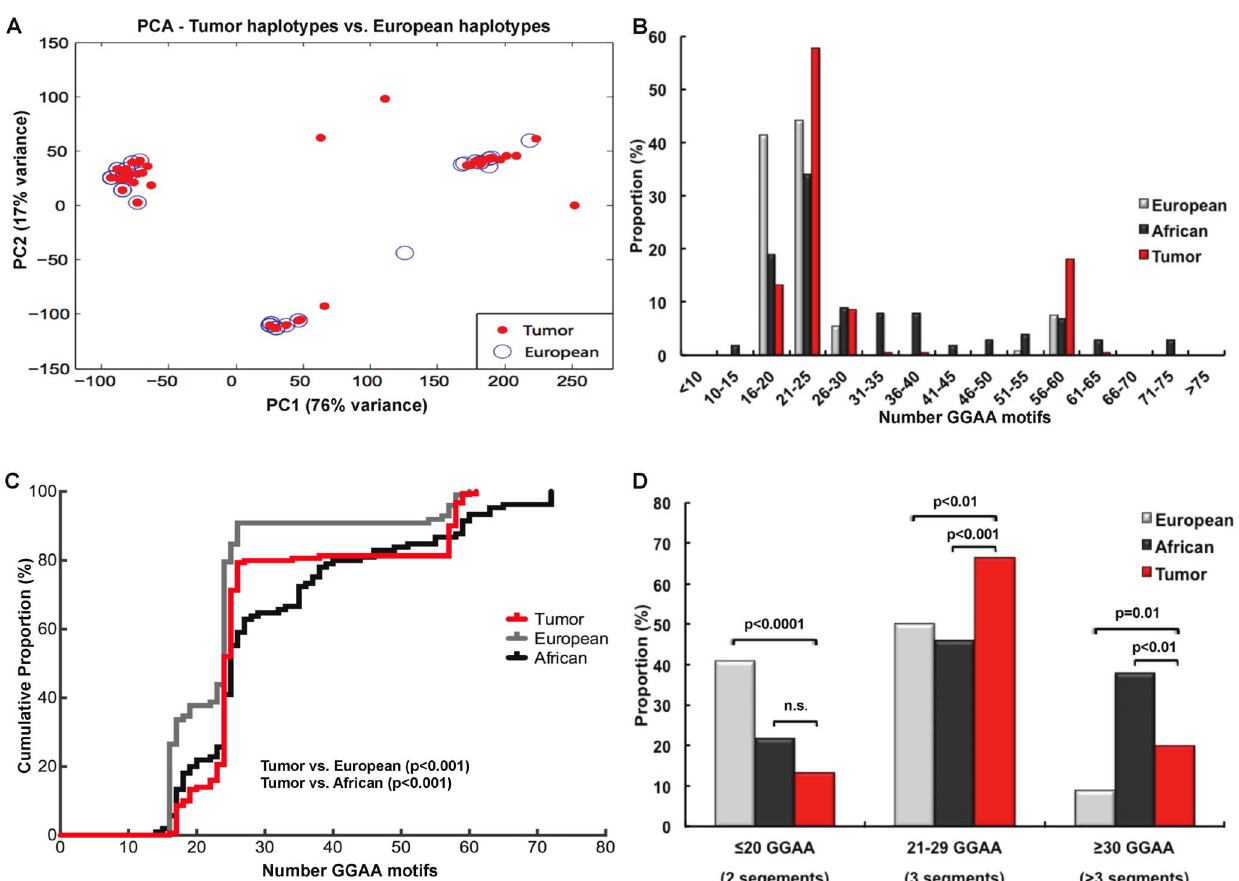
Figure 3. NR0B1 GGAA-microsatellites are polymorphic in Ewing sarcoma tumors with an allelic distribution different than that of white European and African controls. ( A ) Principal components analysis comparing unique microsatellite haplotypes in tumor samples and white European controls demonstrate three principal sequence clusters, with a high-degree of overlap between the two populations. ( B ) Histogram plots comparing the distribution frequency of NR0B1 GGAA-microsatellite haplotypes in tumors and white European and African controls. Despite the overlapping PCA analysis, an enrichment of haplotypes containing 21–25 and 56–60 GGAA motifs was observed in tumor samples. Relative to white Europeans, a depletion of haplotypes containing 16–20 GGAA motifs was also noted in tumors. ( C ) Cumulative density plots for each study population similarly demonstrate the enrichment of haplotypes containing 21–25 and 56–60 GGAA motifs in tumors. The distribution of these haplotypes in tumors is significantly different from both white Caucasian and African populations (KS test, p , 0.001). ( D ) Stratifying haplotypes according to the major sequence types identified in the PCA demonstrates that intermediate (3 segment) GGAA-microsatellites are more enriched in tumors and larger multisegment haplotypes ( . 3 segments) were also more enriched compared to white Europeans, although markedly less than Africans. Control white European and African population data from [12]. doi:10.1371/journal.pone.0104378.g003 PLOS ONE |